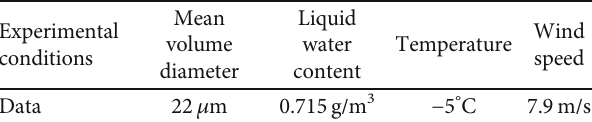
Figure 4: Total and static pressure outputs of the pitot tube after blocking by rime ice. O – A: the entire air pressure detection system is stationary. A – B: the L-shaped pitot tube is placed into the ice wind tunnel at point A, such that the total pressure hole is facing the incoming wind direction. B – C: the spray system is turned on at point B. C – D: after point C, the pitot tube is in an icy state, ice accumulates, and the icing state is rime ice (as shown in Figure 5). After point D, the ice shape is basically stable. Table 3: Parameters of ice blocking experiment